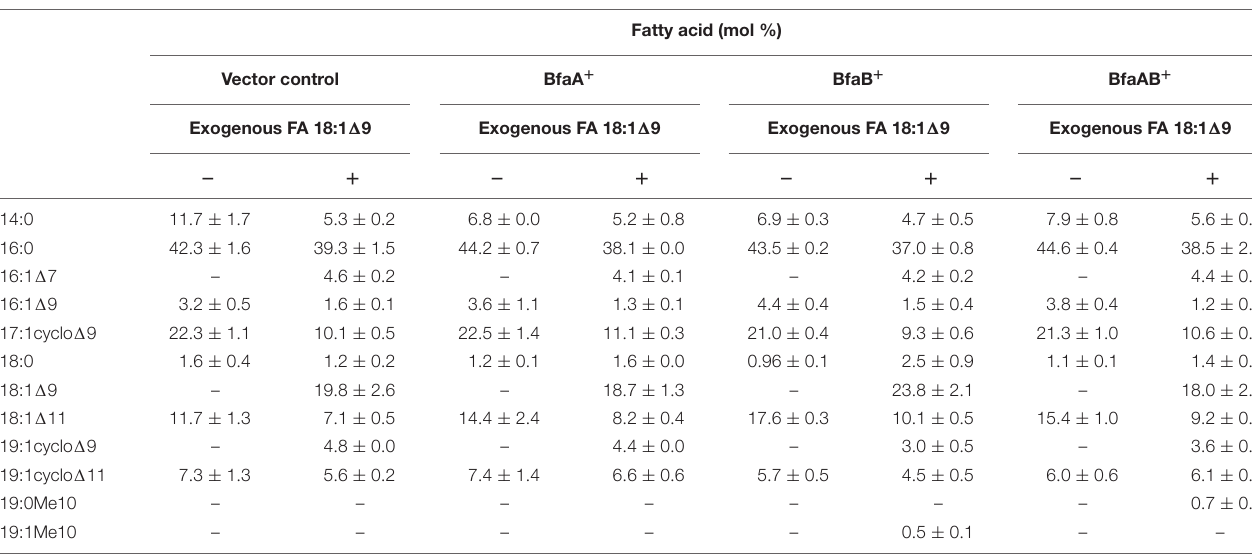
FIGURE 3 | Modification of the Shine–Dalgarno (SD) sequence upstream of the coding sequence of the methyltransferase WP_048472121. (A) The native genomic sequences encoding the FAD-binding oxidoreductase (FADO) WP_08472120 and the SAM-dependent methyltransferase WP_048472121 was shown. (B) The genomic sequences substituted the two nucleotides in upstream of WP_048472121 without alteration of the encoded polypeptide sequence was shown. The substituted nucleotides are shown by a bold, red-colored font. (C) The genomic sequences inserted 14 nucleotides including the canonical SD sequence from Escherichia coli between FADO and WP_048472121. The inserted nucleotides are shown by a bold, blue-colored font. The translated amino acid sequences are shown. ∗∗∗ Indicates the stop codons. –15 and –5 indicate positions from the translational start codon of WP_048472121. Putative SD sequences were underlined. TABLE 2 | Fatty acid composition of E. coli